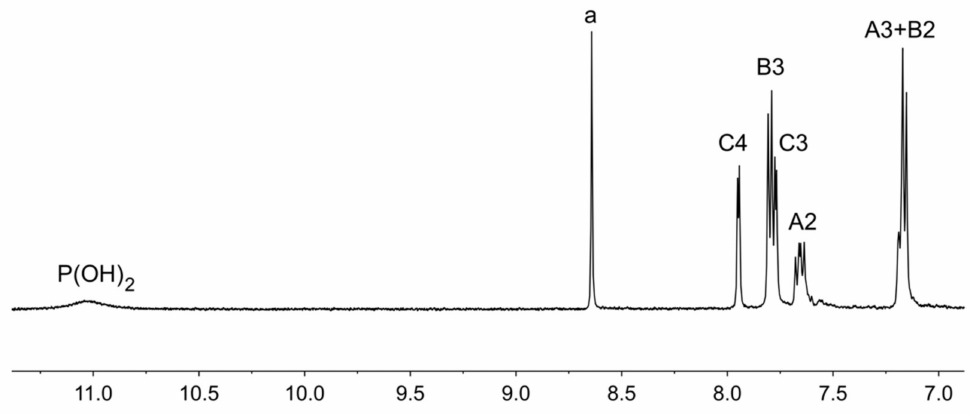
Figure 1. The 1 H NMR spectrum (500 MHz, DMSO- d 6 ) of PP1